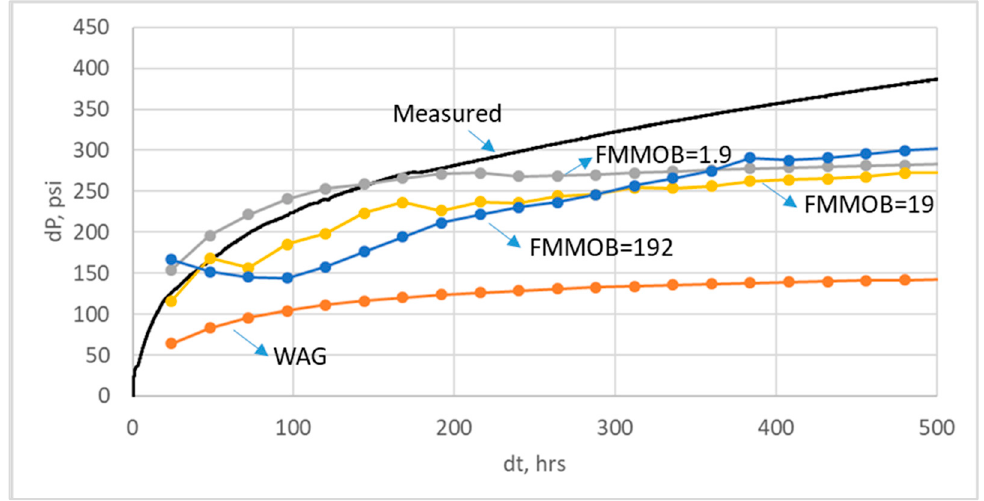
Figure 11. Simulated transient pressures during the fall-off period with different foam strength pa- rameters.